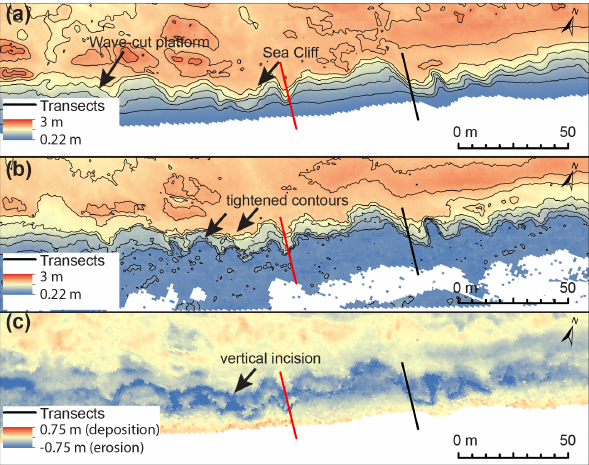
Figure 9. (a) 2016 lidar collected by the USACE at Site 1. Contour interval is 0.3m. Arrows point to locations on the beach where ele- vation and contour spacing indicate either the sea cliff or the shore platform. (b) 2017 lidar collected after Hurricane Harvey; © Bureau of Economic Geology. Contour interval is 0.3m. (c) Difference be- tween (a) and (b) . The arrow points to the site of vertical incision. Transects are indicated by the black and red solid lines.